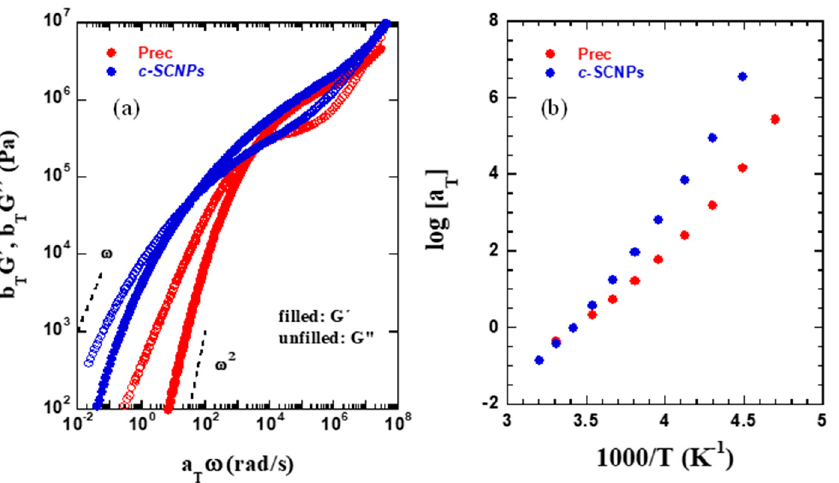
Figure 3. ( a ) Rheological master curves (reference temperature: 293 K) for precursor and c -SCNPs, built by using the shift factors shown in ( b ).